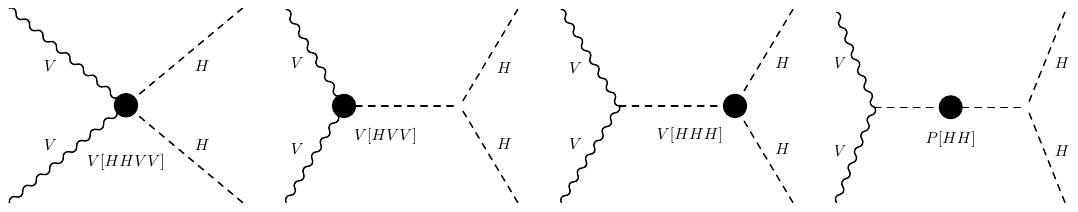
Figure 18 . The structure of one-loop e(cid:11)ects in the HHV V amplitude expressed via form